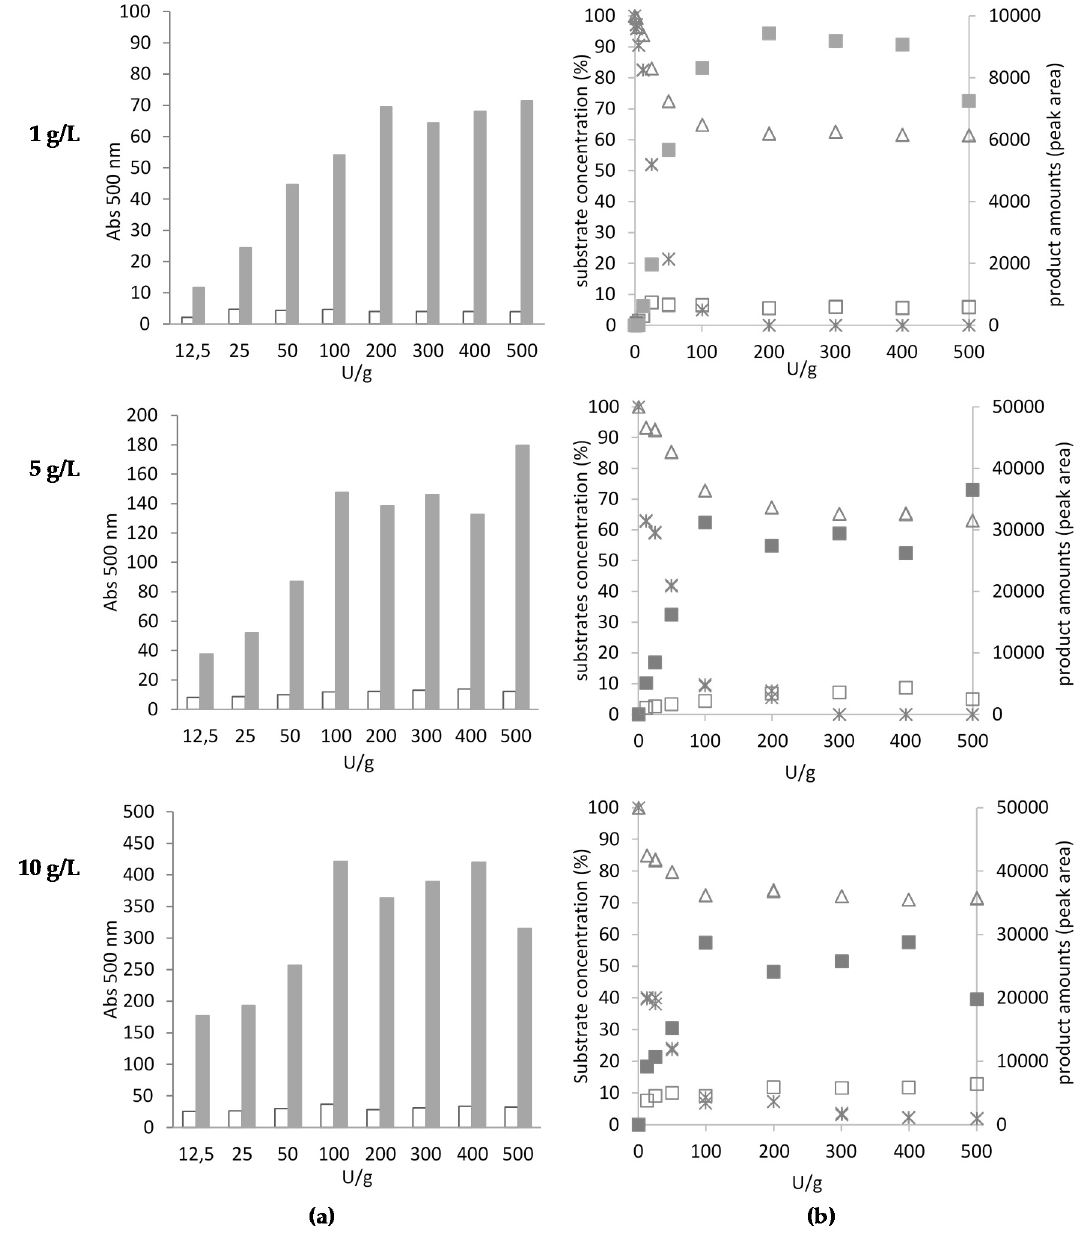
Figure 4. E ff ect of LAC activity (U / g) on the amount of AB2 dye expressed as the absorbance at 500 nm, dissolved in methanol (filled bars) and water (empty bars) fractions ( a ) and the peak area obtained from HPLC analysis ( b ) of methanol (filled squares) and water (empty squares) fractions of products after 48-h oxidation. Residual concentrations of A and B2 substrates (%) were analysed using HPLC; substrates are marked as follows: substrate A residual concentration (%)—cross; substrate B2 residual concentration (%)—triangle.